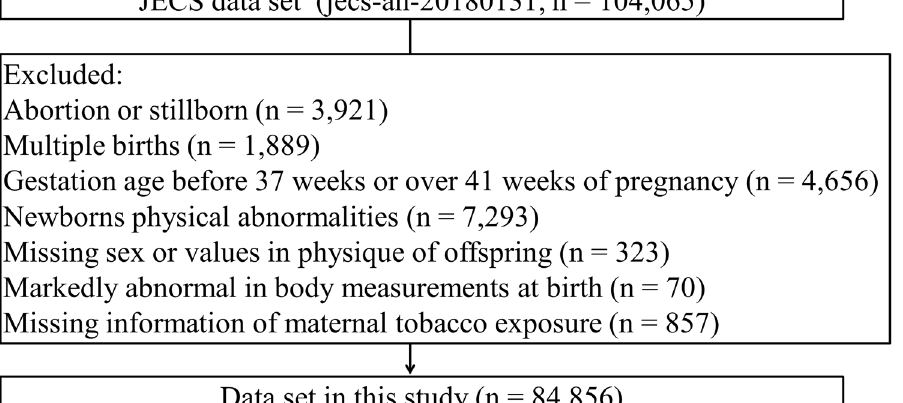
Figure 1. Flowchart of participant selection from the Japan Environment and Children’s Study (JECS) birth